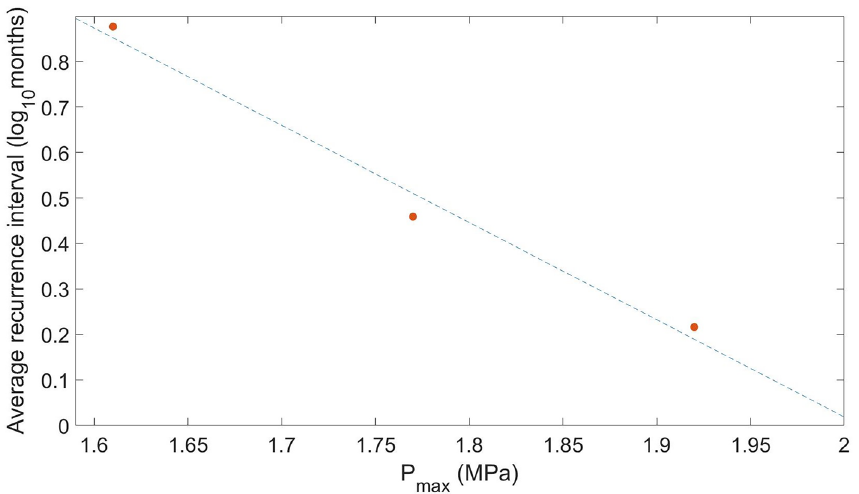
Figure 7. Average recurrence interval versus P max . Average recurrence interval of triggered cluster versus P max for model 1 (Eq. 5). The dashed blue line shows the decreasing trend. The trend seen here is similar to that observed for model 2 (Eq. 6), as seen in Supplementary Fig. S3. This is an example of the similarity between the models. The qualitative conclusion that increasing P max shortens the time between the earthquakes in the triggered cluster is the same across both scenarios. Similar observations can also be made for change in r P